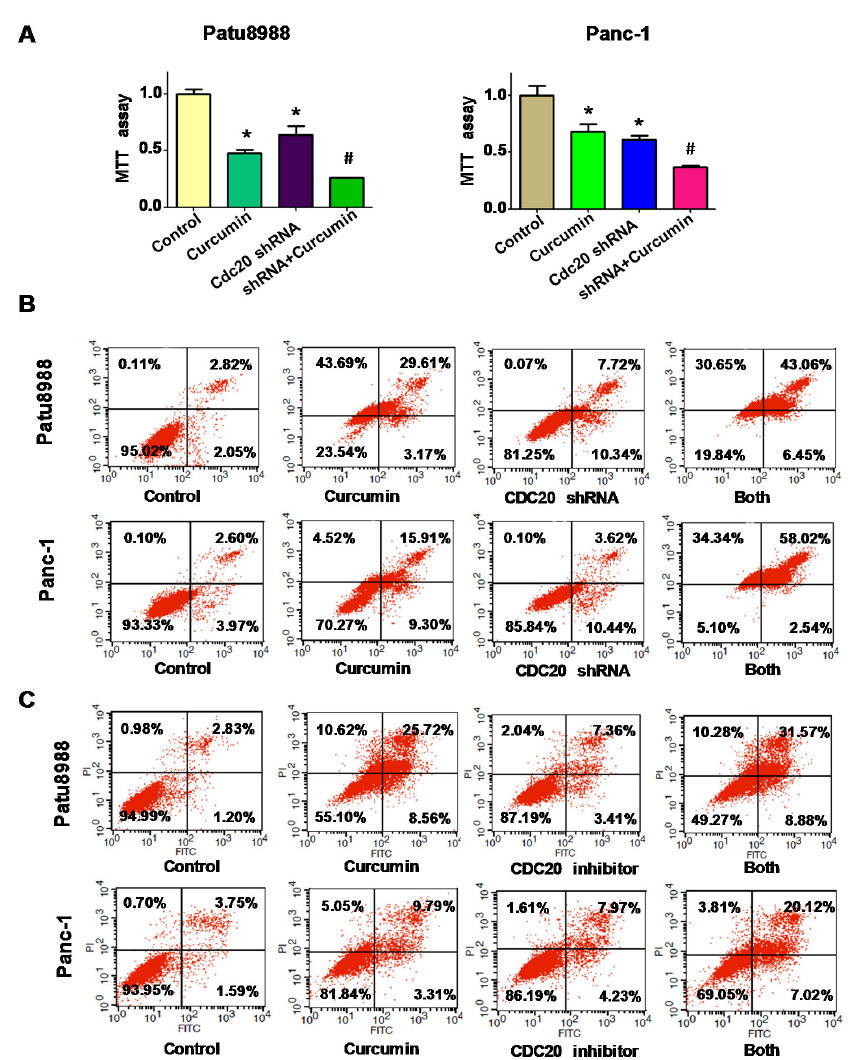
Figure 5. The effect of Cdc20 downregulation on cell growth and apoptosis. ( A ) MTT assay was conducted to determine the effect of Cdc20 shRNA in combination with curcumin treatment on PC cell growth. * p < 0.05, compared with control; # p < 0.05 compared with curcumin treatment or Cdc20 shRNA transfection; ( B ) Apoptosis was detected by flow cytometry in PC cells with Cdc20 shRNA transfection and curcumin treatment. Both: curcumin + Cdc20 shRNA. C. Apoptosis was analyzed by flow cytometry in PC cells with Cdc20 inhibitor (50 μ M Apcin) and curcumin treatment. Both: curcumin + Cdc20 inhibitor. PI: propidium iodide; FITC: fluorescein isothiocyanate.